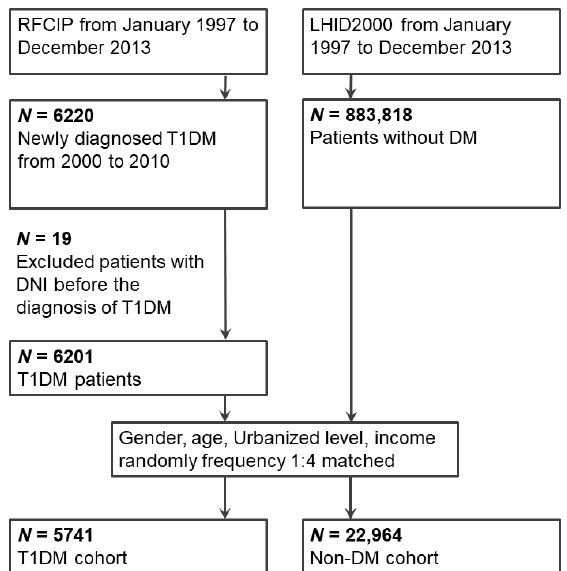
Figure 1. Enrollment schema of the study and comparison cohorts. Abbreviations: RFCIP, Registry for Catastrophic Illness Patients; LHID2000, Longitudinal Health Insurance Database 2000; DM, diabetes mellitus; T1DM, type 1 diabetes mellitus; DNI, deep neck infection.